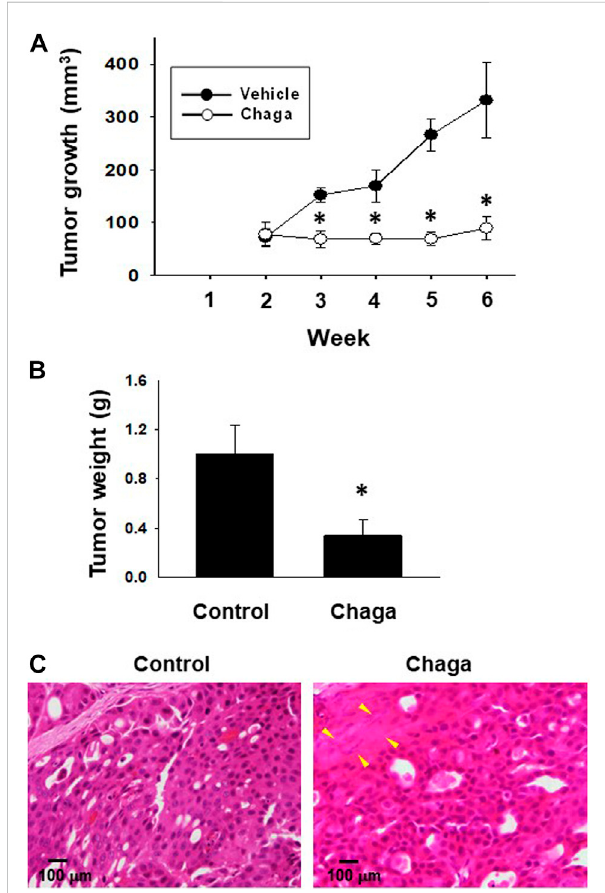
FIGURE 8 Effects of Chaga on tumor growth against xenografted DBCO in immunode fi cient mice. After DBCO cells were subcutaneously inoculated into the back of SCID mice and tumors were formed, Chaga was administered to the mice at the concentration of 6 mg/kg for 4 weeks and the vehicle was administered at the same volume to the control group. Thereafter, the tumor volume was calibrated weekly for 4 weeks (A) , (n = 4). The tumor tissue of each group was dissected, weighed, and used for analysis. The tumor growth (A) and weight (B) between Chaga- or vehicle-administered mice were analyzed and graphed. Results were expressed as mean ± S.E.M. * p < 0.05 vs. control. Representative H&E staining images of the tumor tissue sections from Chaga- or vehicle- administered mice (C) . Scale bar: 100 μ